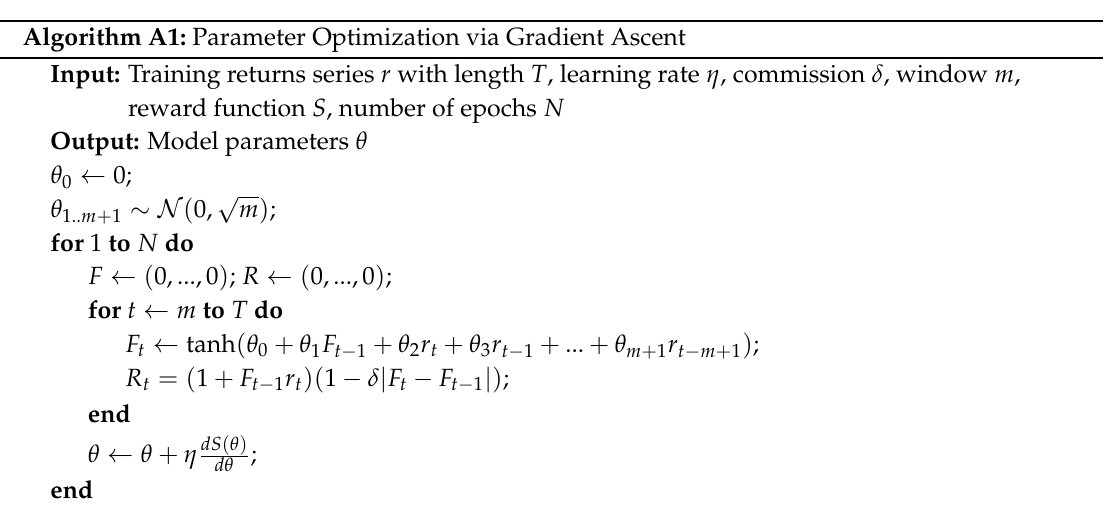
Algorithm A1: Parameter Optimization via Gradient